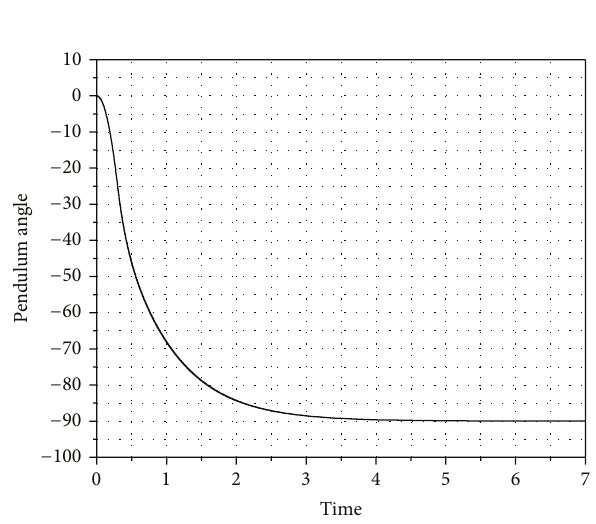
Figure 4: Single pendulum beam.